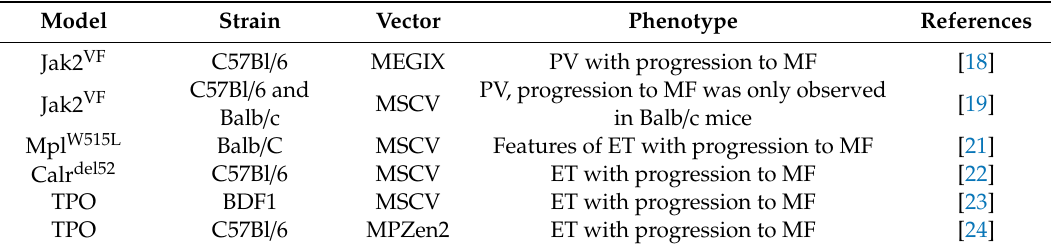
Table 1. Models of myelofibrosis generated by retroviral overexpression and bone marrow transplantation in mice. ET: essential thrombocythemia, MF: myelofibrosis, TPO: thrombopoietin, PV: polycythemia